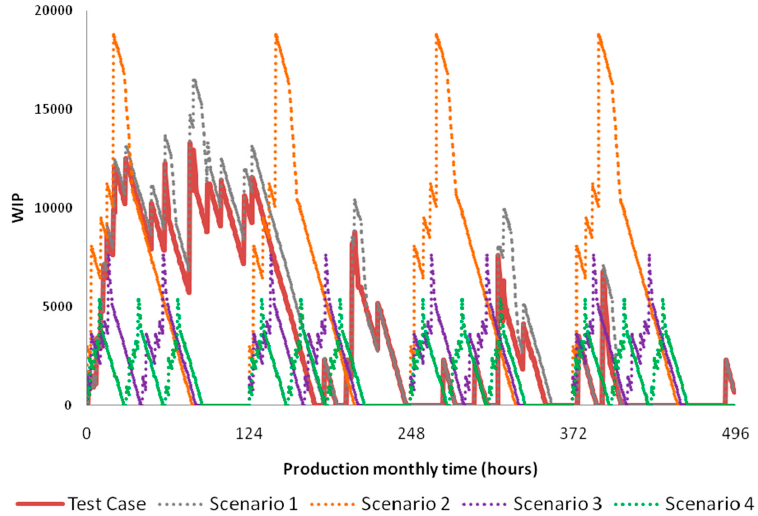
Figure 7. Scenarios performance regarding WIP, as presented preliminarily in Reference [23].